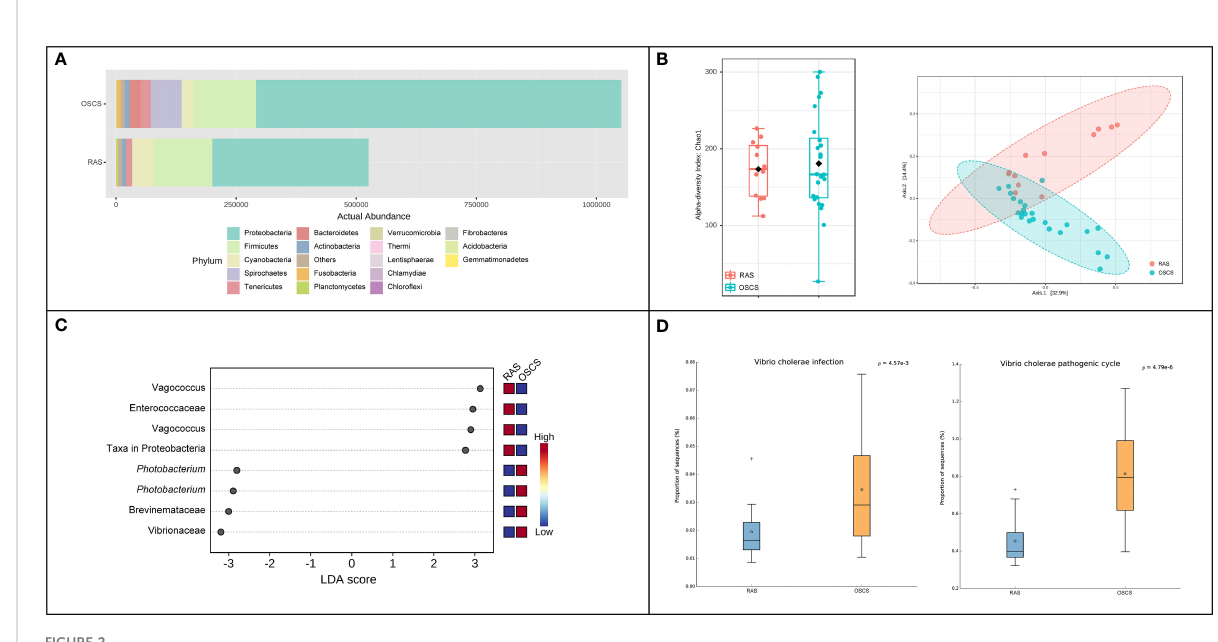
FIGURE 2 Intestinal bacterial communities in RAS and OSCS. (A) Bacterial abundance at phylum level; (B) LEfSe analysis of ASVs in intestinal bacterial communities between RAS and OSCS samples; (C) Alpha and beta diversity analyses of intestinal bacterial communities between RAS and OSCS samples; (D) Differences of functional pathways of intestinal bacterial communities between RAS and OSCS